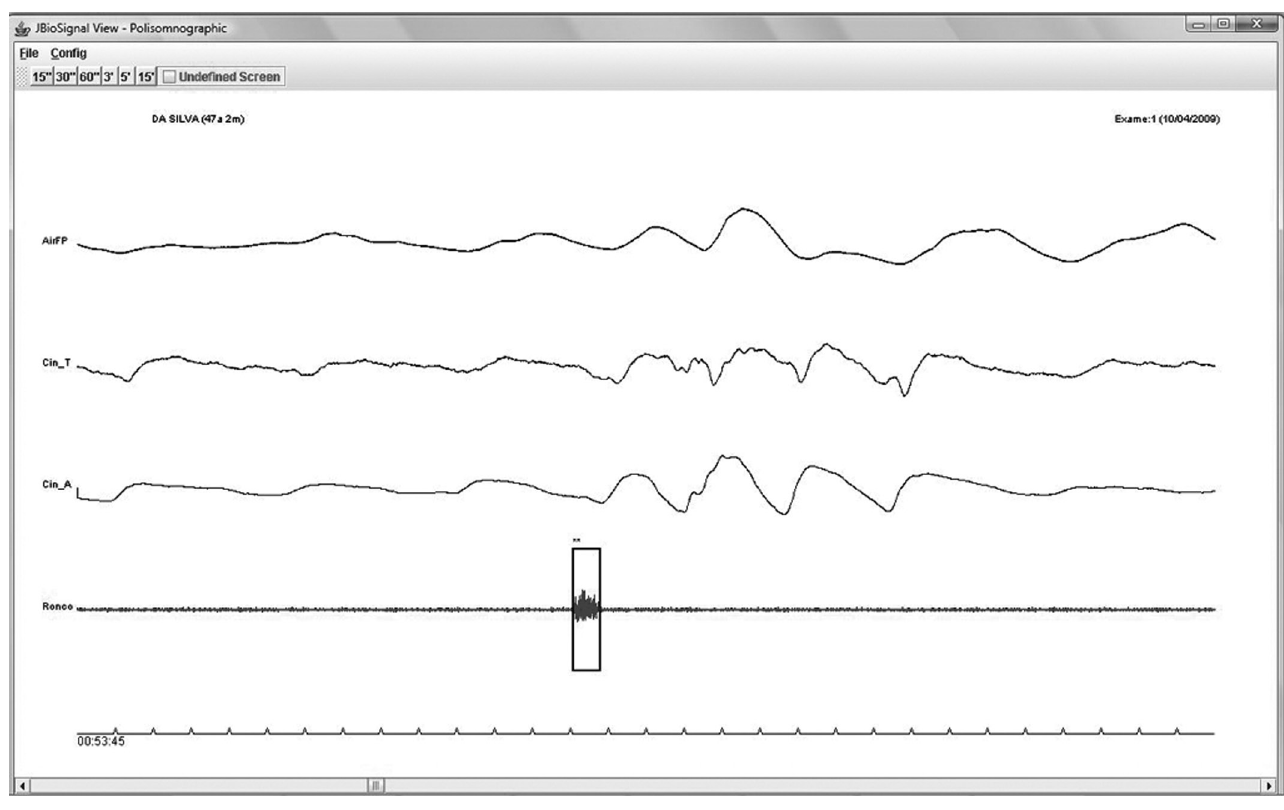
Figure 7. Artifact (non-snore) - Event classified as an Table 1. Descriptive statistics of the study population.